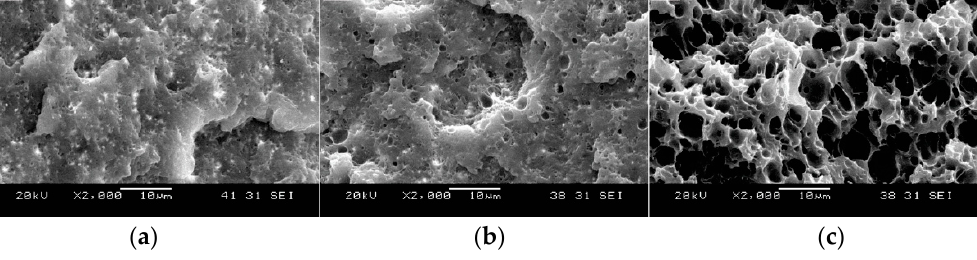
Figure 3. PLA/CNFs (1 wt%) foams micrographs at ( a ) 100 °C, ( b ) 110 °C, and ( c ) 120 °C. Reprinted from Ding [120].